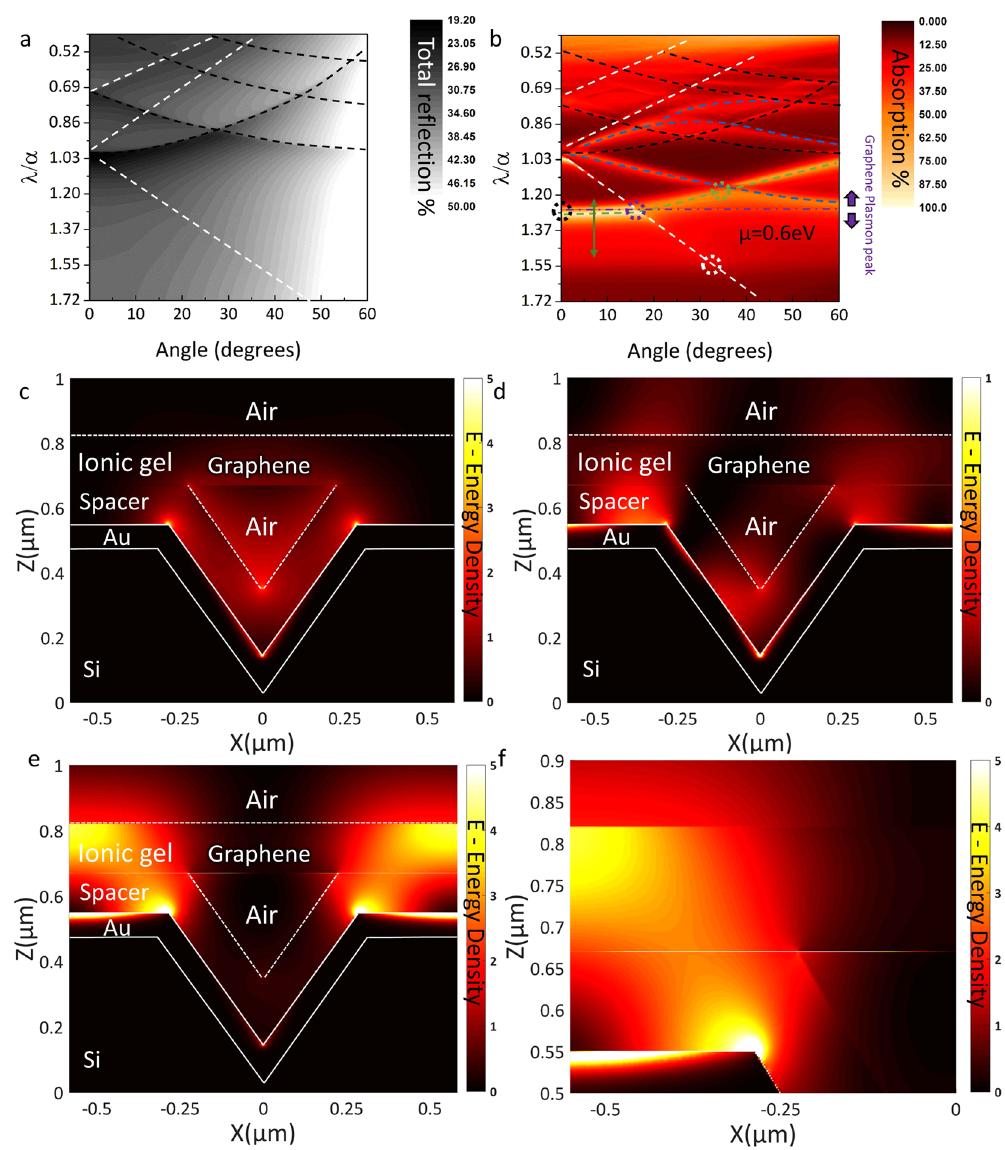
Figure 6. RCWA simulation of the device showing ( a ) total reflection data for a range of photon incident angles plotted versus normalized frequency (wavelength/pitch) when not including the gold back reflector and graphene layer. White dashed lines correspond to 1 st order diffractive modes and black dashed lines to dispersive modes associated with the 2-dimensional grating geometry. ( b ) absorption spectra now including the graphene and Au layers. The extra green (fundamental mode) blue and purple lines appearing correspond to Au and Graphene plasmon modes respectively. ( c – e ) show FDTD simulation results from the white, green, and purple circle markers in b. respectively. ( f ) Zoomed in version of ( e ) showing that the coupling that occurs between the gold and graphene plasmon